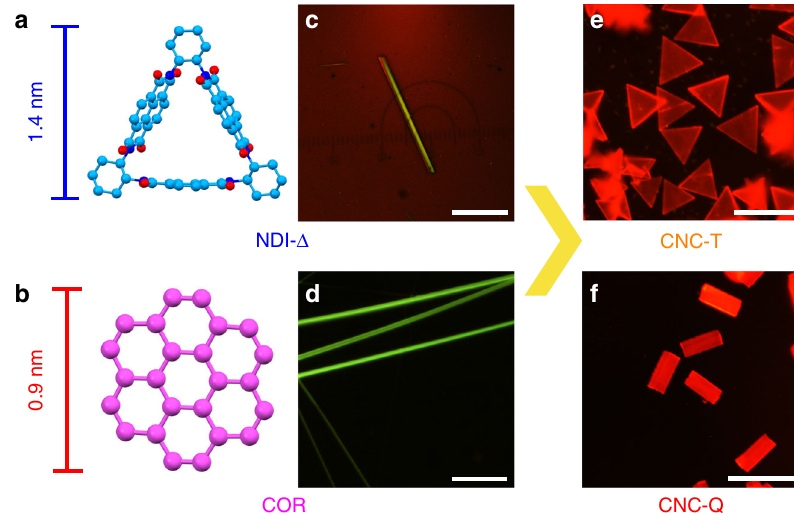
Fig. 1 Crystal engineering of NDI- Δ , COR, CNC-T, and CNC-Q. a Solid-state structure of NDI- Δ . C light blue, N dark blue, O red. b Solid-state structure of COR . C pink. c Fluorescence microscopy image of an NDI- Δ crystal illustrating that it exhibits a 1D morphology and emits green fl uorescence. Scale bar: 20 μ m. d Fluorescence microscopy image of COR crystals, which display a 1D morphology and green fl uorescence. Scale bar: 40 μ m. e Fluorescence microscopy image of CNC-T , which exhibits a unique triangular morphology and red fl uorescence. Scale bar: 50 μ m. f Fluorescence microscopy image of CNC-Q , which displays a quadrangular morphology and red fl uorescence. Scale bar: 50 μ